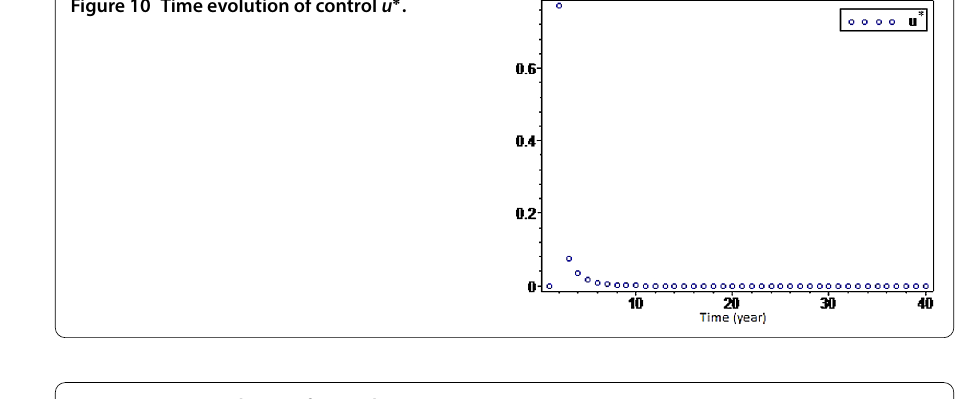
Figure 11 Time evolution of control v ∗